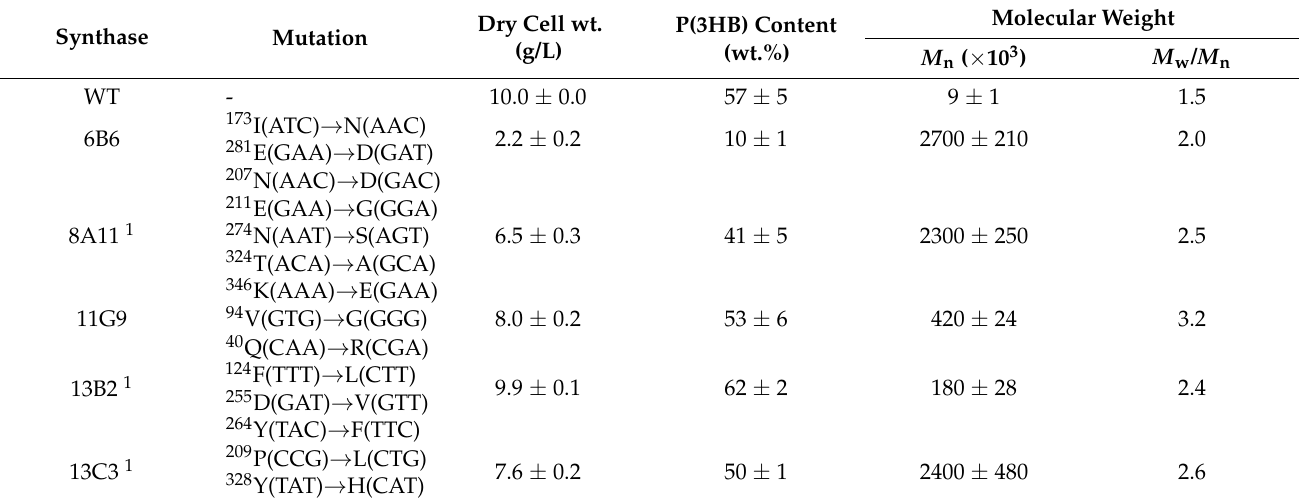
Figure 3. Distribution pattern of HPLC peak ratio in the PhaRC YB4 mutant library. Recombinant strains were cultured in 96-well plates and analyzed by HPLC after alkaline treatment. Y-axis is shown as the value of peak area of crotonic acid divided by that of benzyl alcohol. The larger the value, the higher is the DP of PHA. Dashed line represents the range of the result from wild-type. Table 2. P(3HB) production by E. coli DH5α expressing wild-type or random mutated PhaRC YB4 .